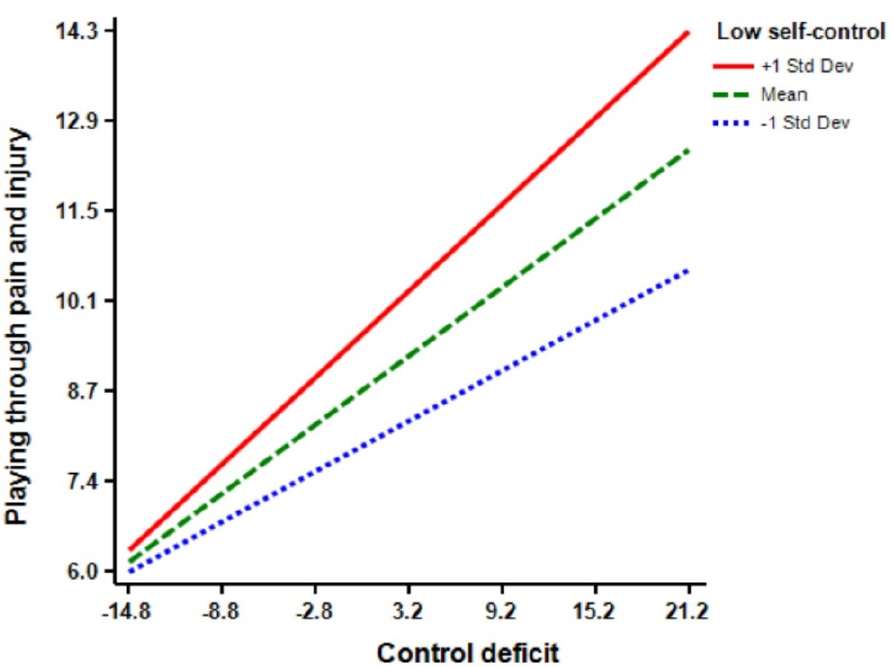
Figure 3. Low self-control by control balance deficit interaction.